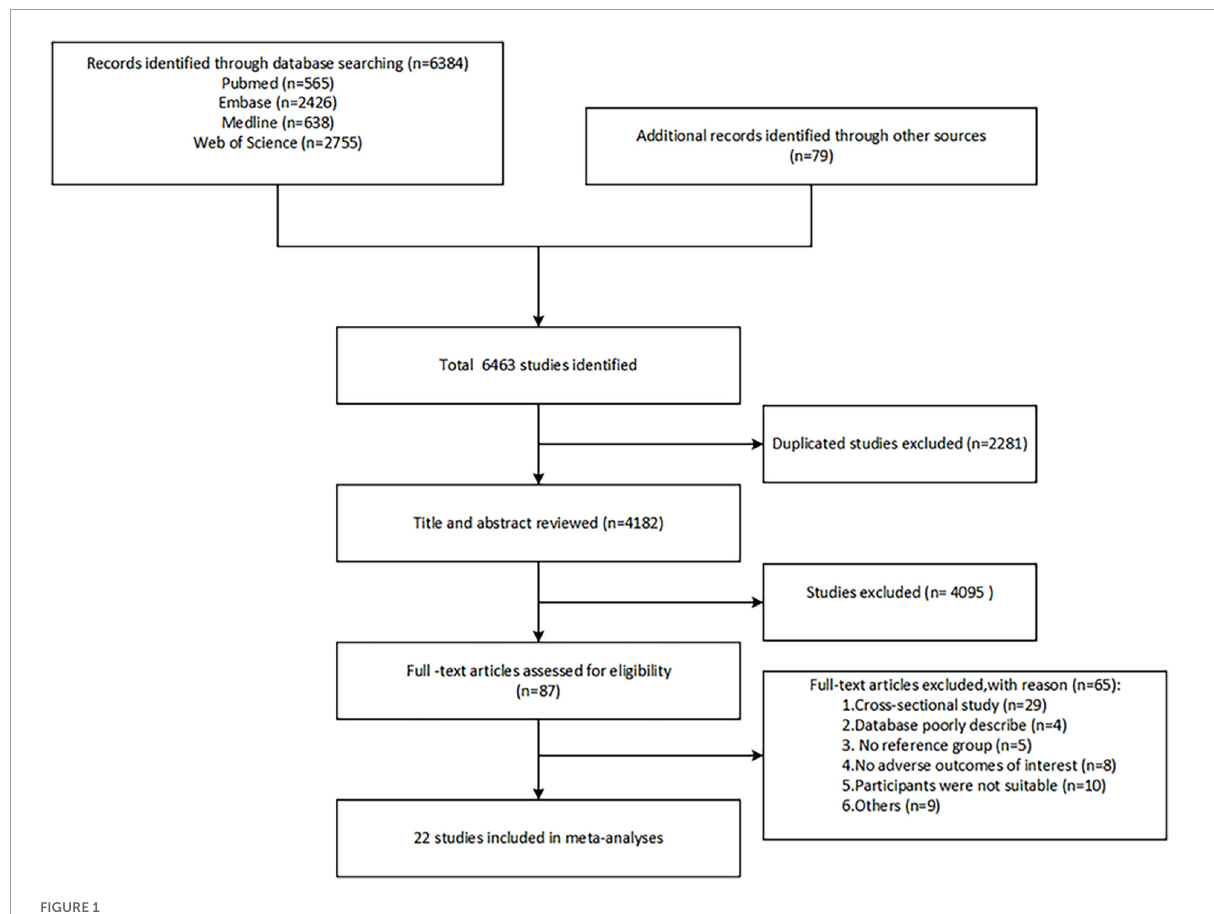
FIGURE1 Flow diagram of the selection process of the studies.